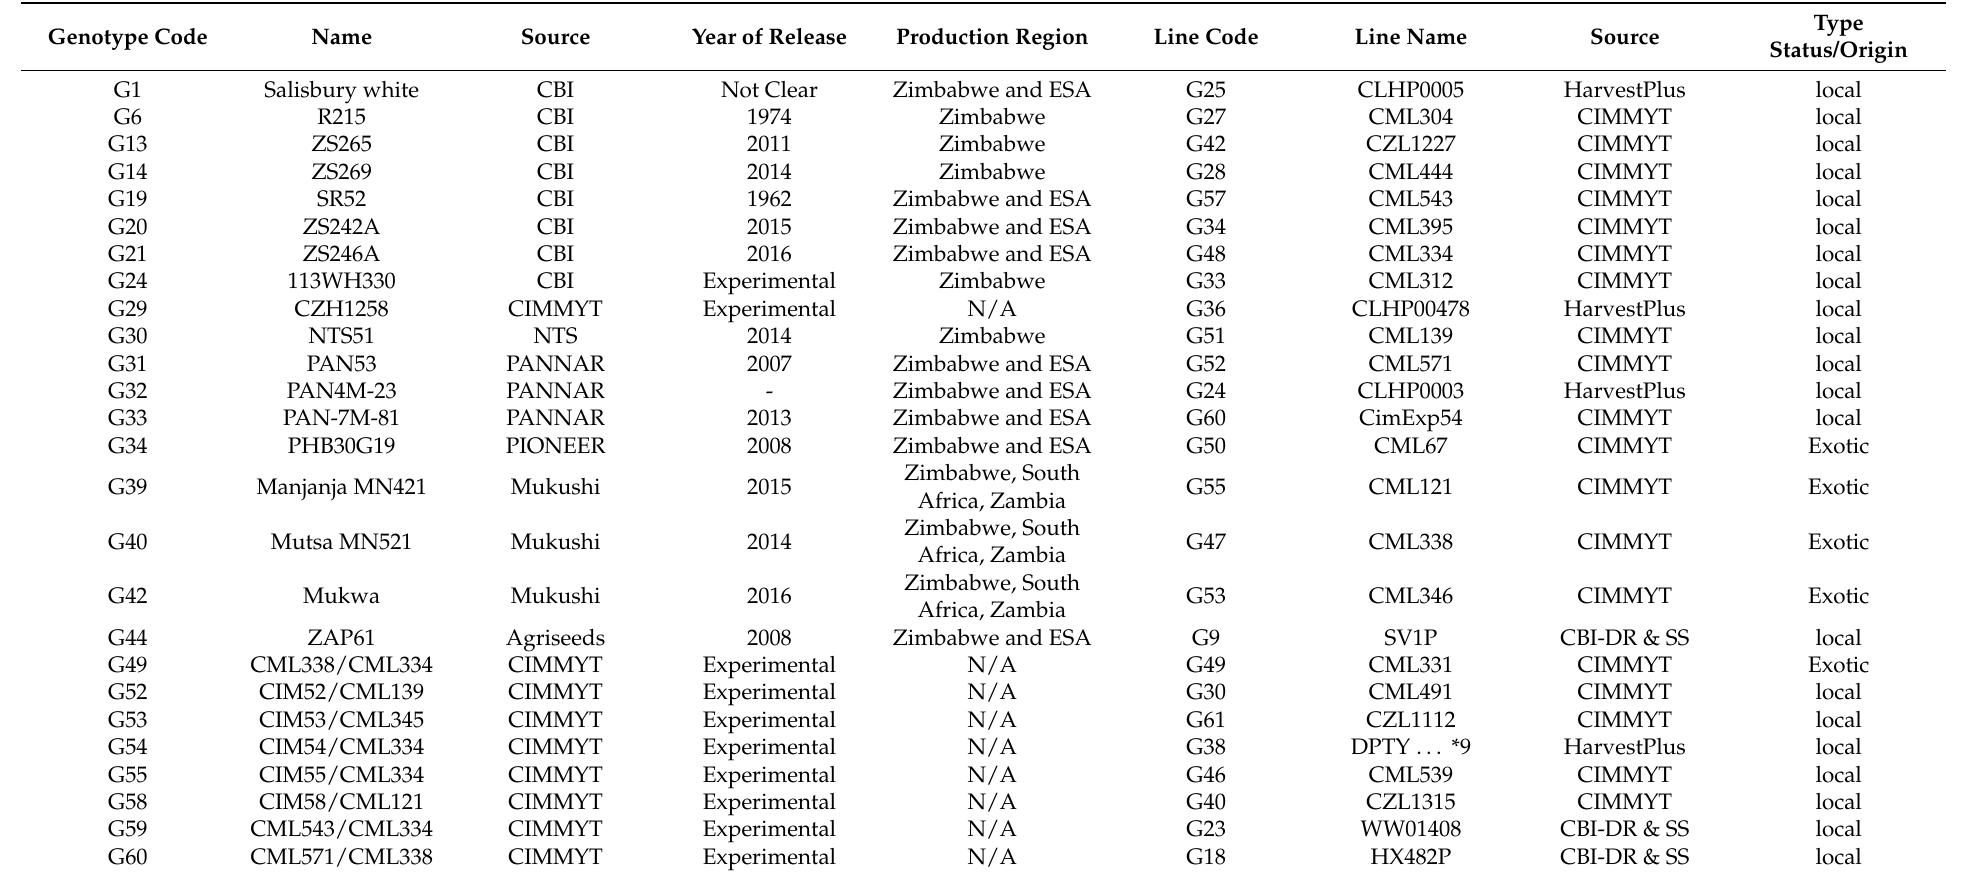
Table 1. Description of genotypes evaluated for adaptation and stability of performance under natural fall armyworm infestation in Zimbabwe during the 2019–2020 summer